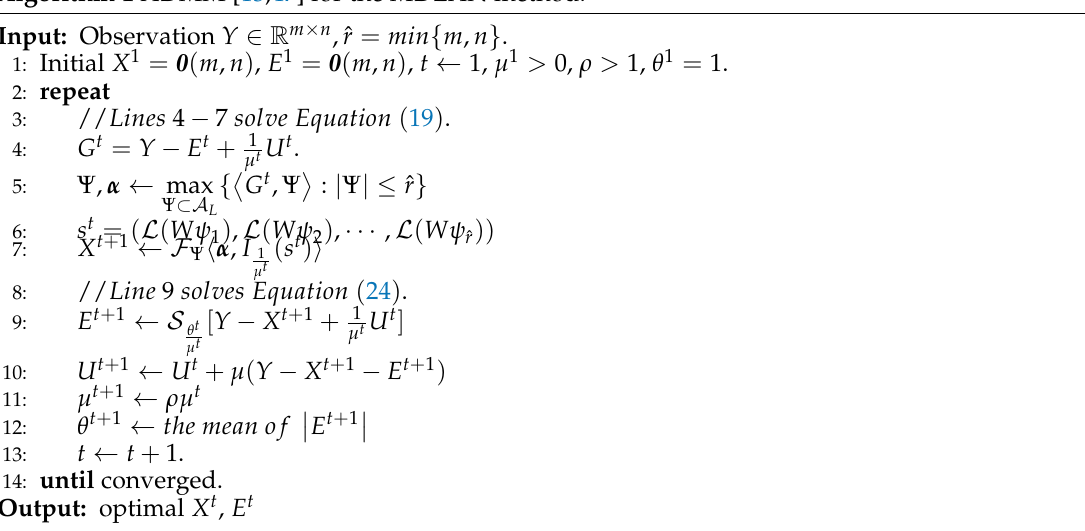
Algorithm 1 ADMM [13,47] for the MDLAN